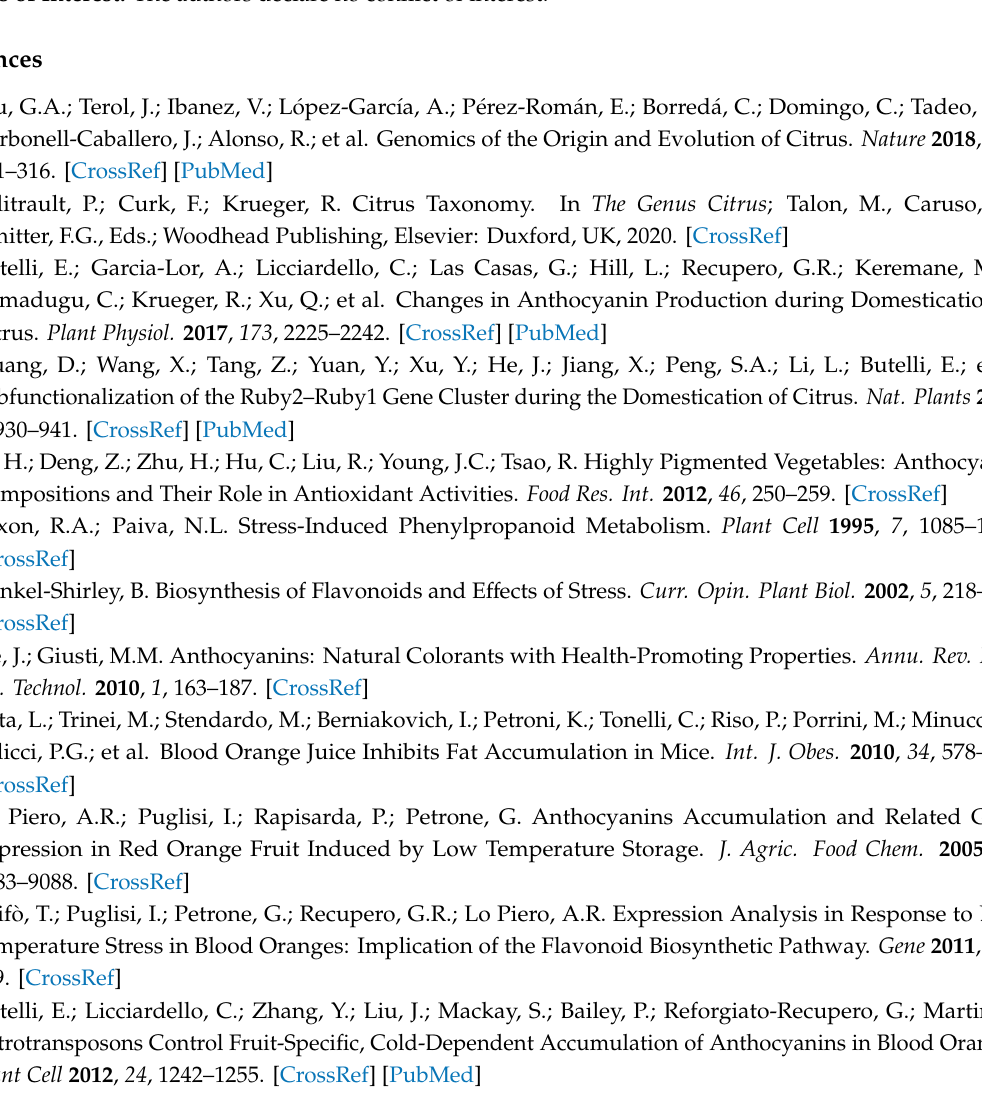
expression analysis. The number of di ff erent nucleotides and the correspondent modification in the amino acid in the primers are reported. Table S2. Anthocyanin and lycopene quantification in the rind of Murraya paniculata and in the flesh of ‘Navel’, ‘Tarocco Lempso’, ‘Tarocco Ippolito’ and ‘Moro’ oranges. Table S3. Significant values of Pearson’s correlation coe ffi cient among gene expressions reported for each tissue. Table S4. Weights and % of explained variance of scaled gene expression of the four components of the PLS model for prediction of petal color intensity. Table S5. Paired test of qualitative presence / absence of anthocyanin pigmentation in petals, rind, flesh / juice, and stigma. Student t -test of normally distributed values of gene expression and Wilcox test for non-normal distributed values of gene expression. Only tissues with at least one significant value are reported. The significant values are shown in